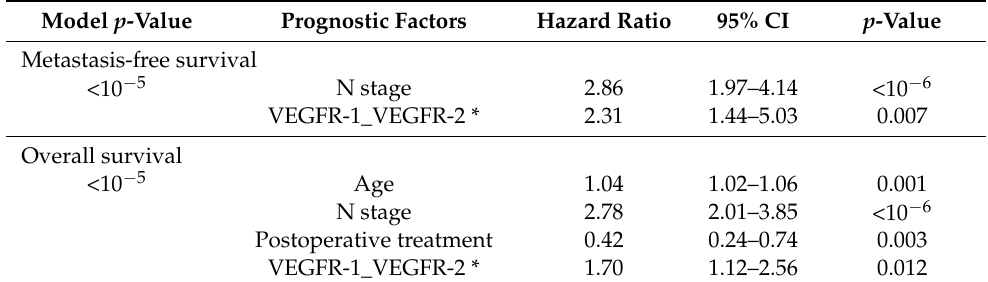
Table 3. Multivariate analysis of metastasis-free survival and overall survival for the VEGFR-1_VEGFR-2 combination ( n = 198). Model p -Value Prognostic Factors Hazard Ratio 95% CI p -Value Metastasis-free survival <10 − 5 N